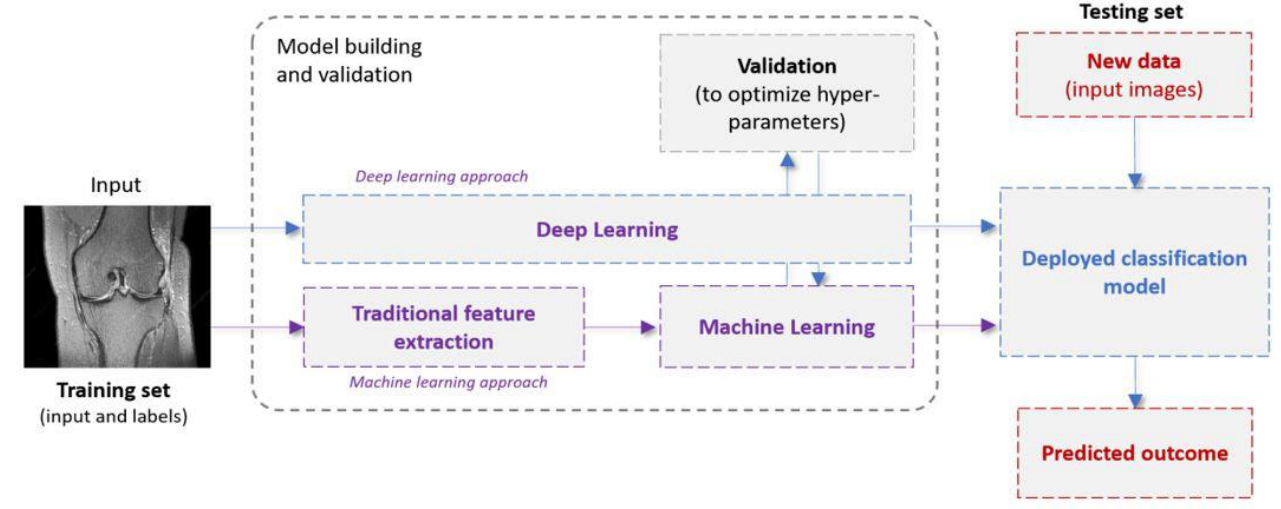
Figure 1. Examples of typical machine-learning and deep-learning pipelines.